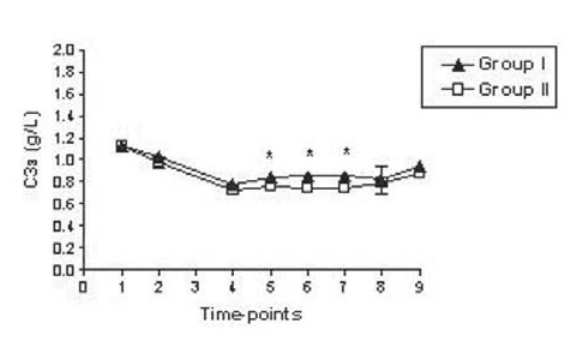
Fig. 1 - C3a over time. Group 1 - no ultrafiltration; Group II - with ultrafiltration. * statistically significant